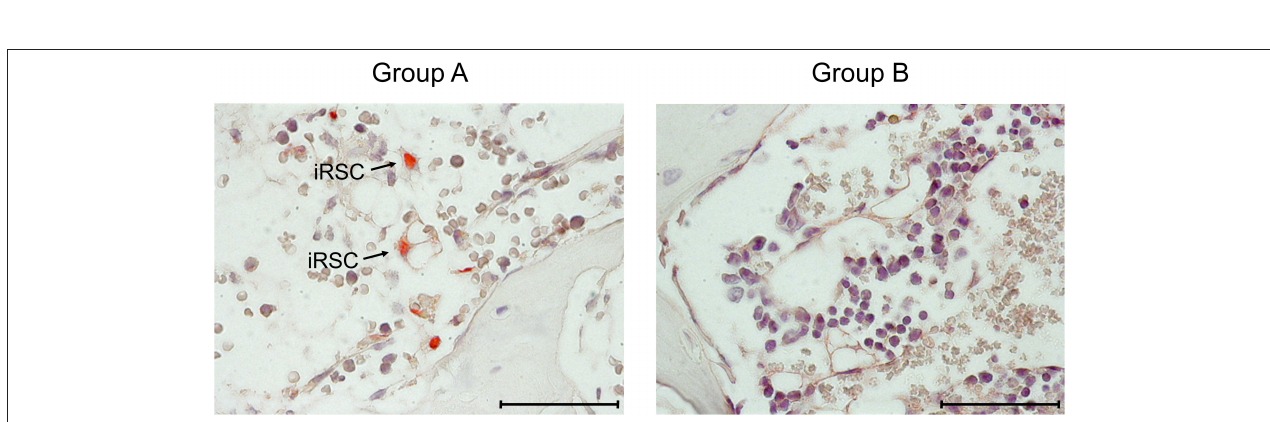
FIGURE 3 | Immunohistological images of stromal infection in BM. Representative IHC images of vertebral BM sections taken on day 14 after HCT and infection. (Red staining) IE1 protein in nuclei of infected cells. Light counterstaining was done with hematoxylin. Arrows point to infected, very typically shaped “reticular stromal cells” (iRSC). (Group A) No therapy. (Group B) Therapy by transfer of CTL. Bar marker: 50 µ m.